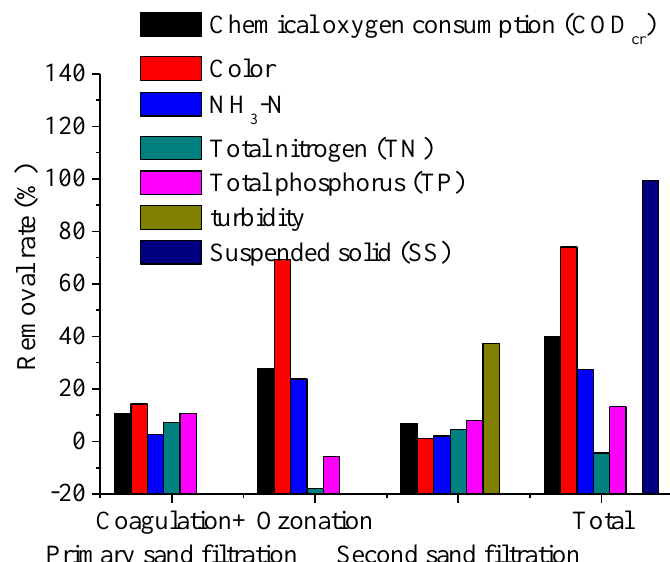
Figure 2. Removal rate of the pollutants during reactive precipitation + primary sand filtration + primary ozonation + second sand filtration .